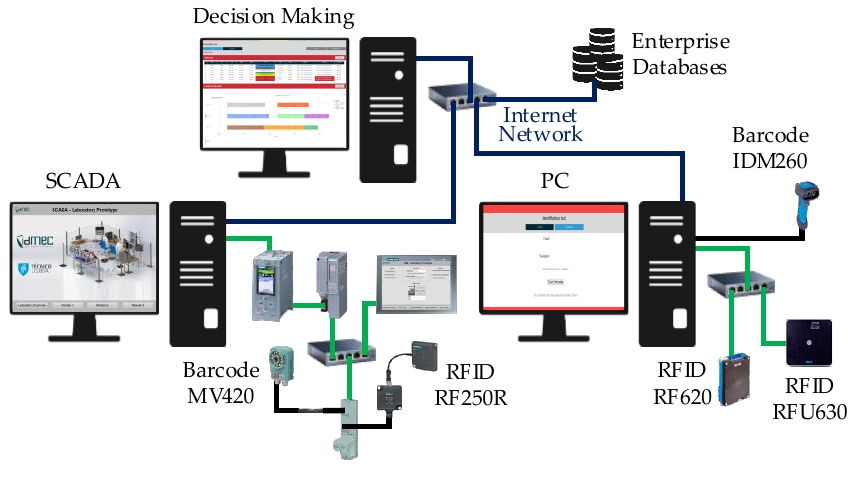
Figure 4. Full system architecture.